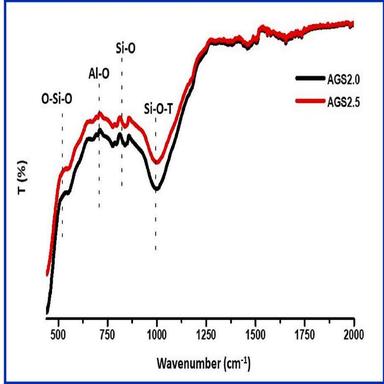
FT-IR spectra of geopolymer compositions after addition of amorphous silica.